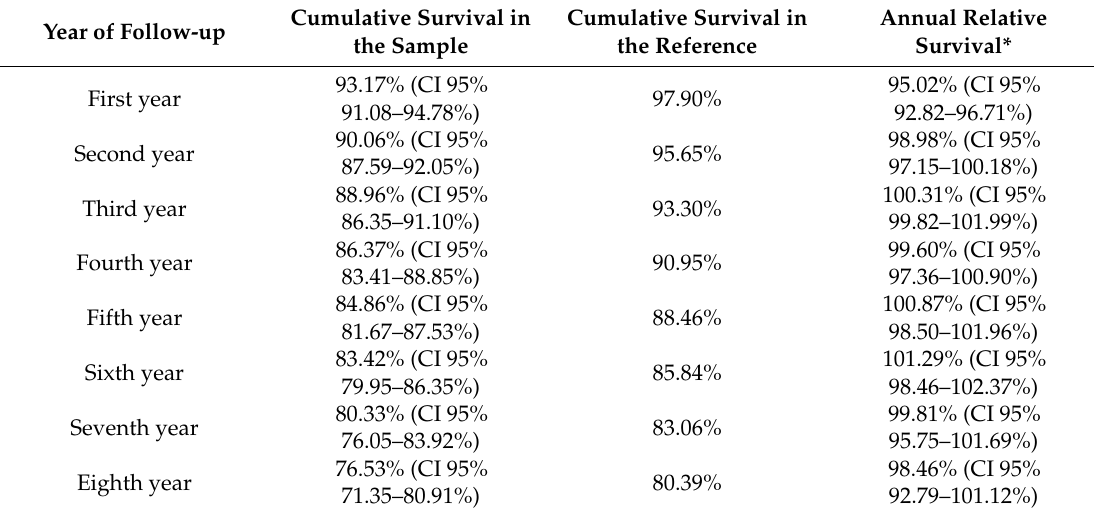
Table 4. Cumulative survival of the sample and the reference population. Annual relative survival is also described for the whole